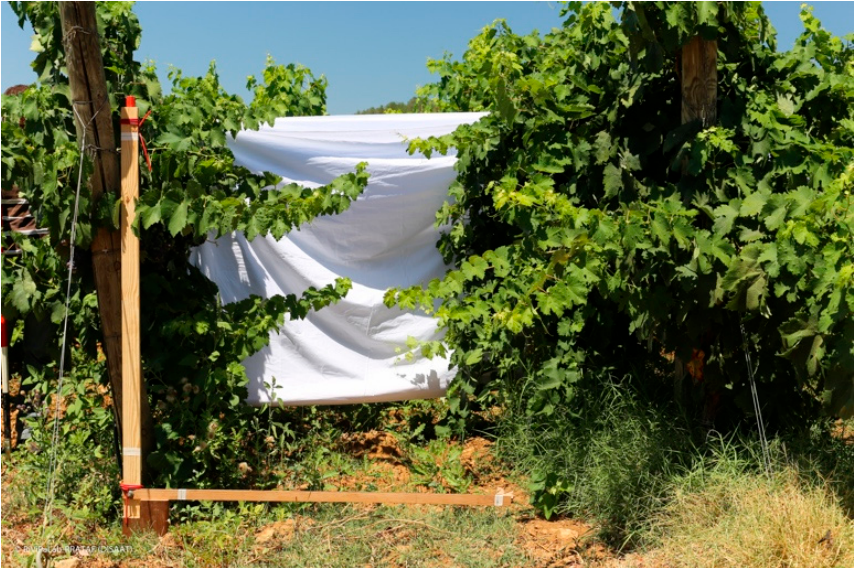
Figure 3. The wooden square angle ruler and sheet arranged on a pair of plants.